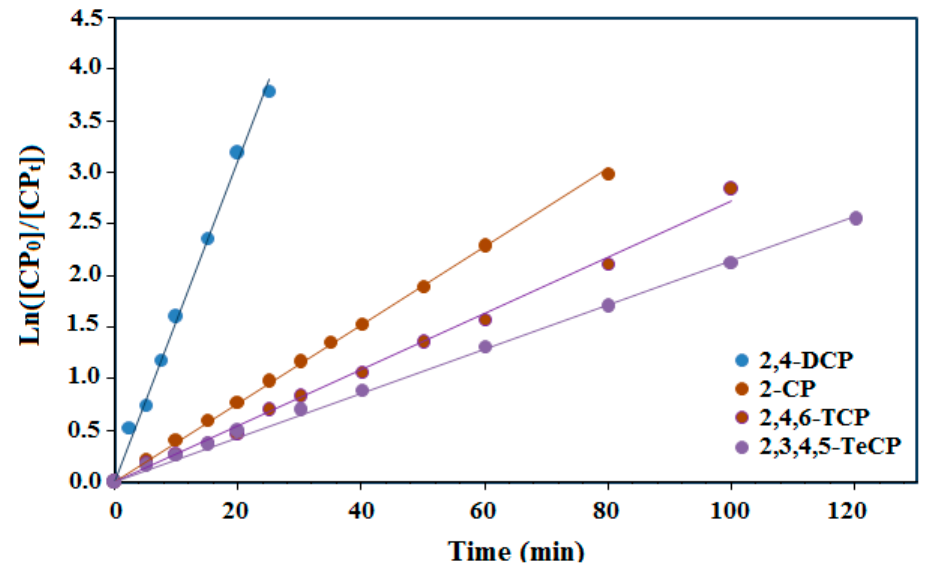
Figure 7. The kinetics model of photodegradation performance of the thin film PdPc(Imz) / ITO / glass at